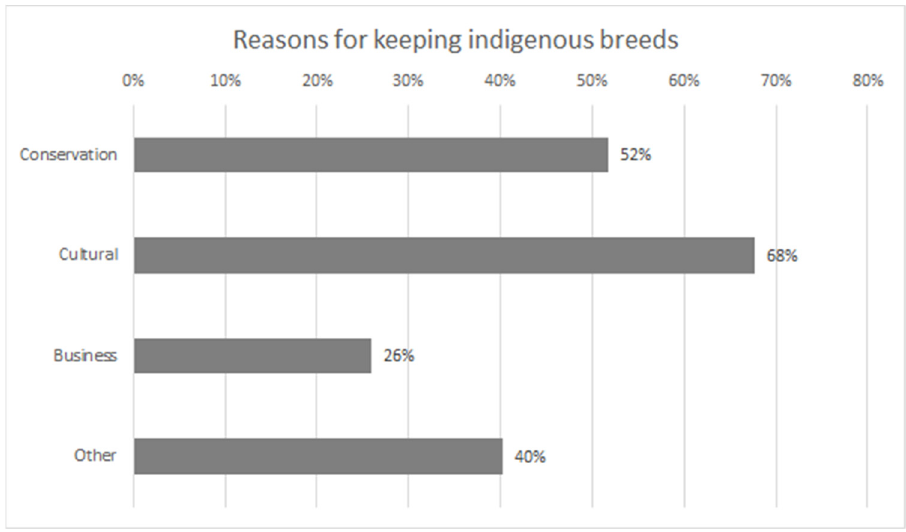
Figure 2. Farmers’ reasons for keeping indigenous breeds. Percentage of respondents for each answer. Multiple answers per respondent